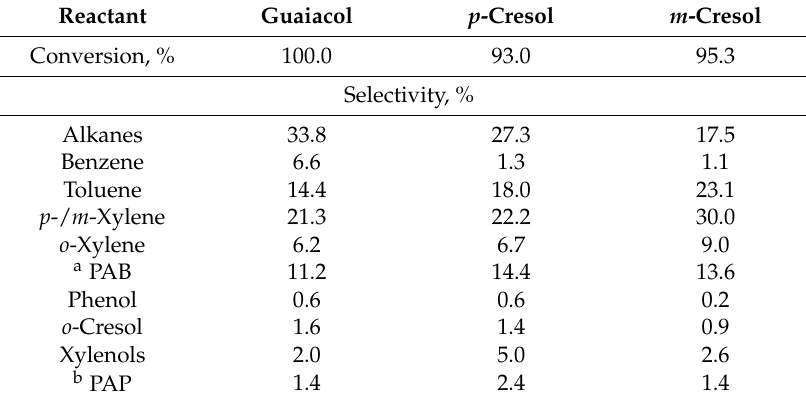
Table 4. Effect of phenols on the product